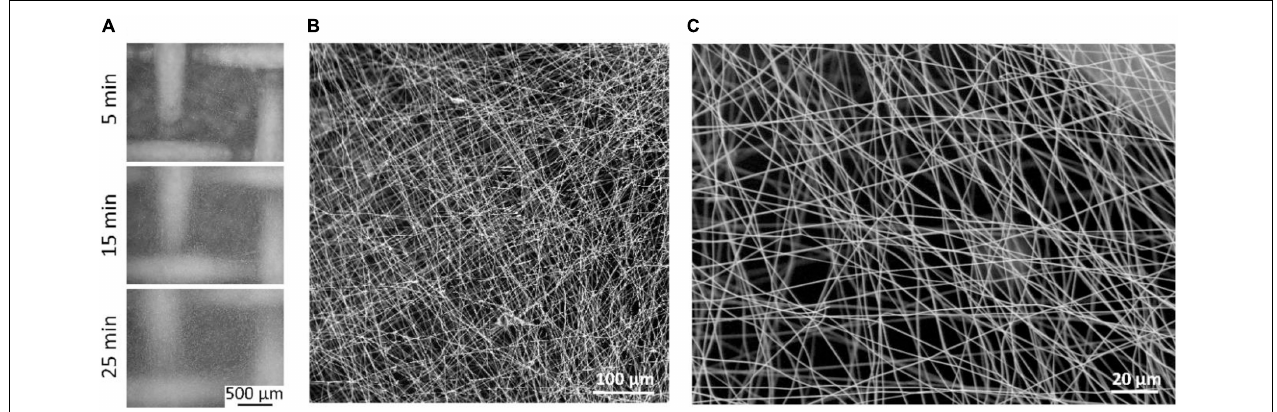
FIGURE 4 | Electrospun substrates by using 15% CA. (A) Optical microscope images of the scaffolds prepared on stainless-steel mesh by using three different spinning times (5, 15, and 25 min). (B) Low magnification and (C) high magnification scanning electron microscopy (SEM) imaging of 25 min electrospun CA scaffolds, as selected candidates for in vitro